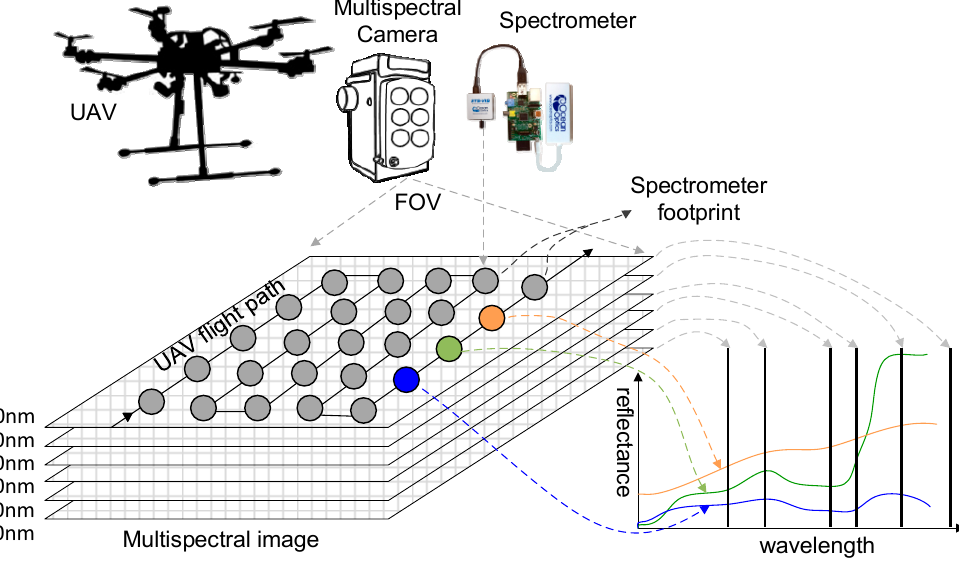
Figure 1. Illustration of unmanned aerial vehicle (UAV) flight system and the concept of data fusion. “FOV” stands for field of view.